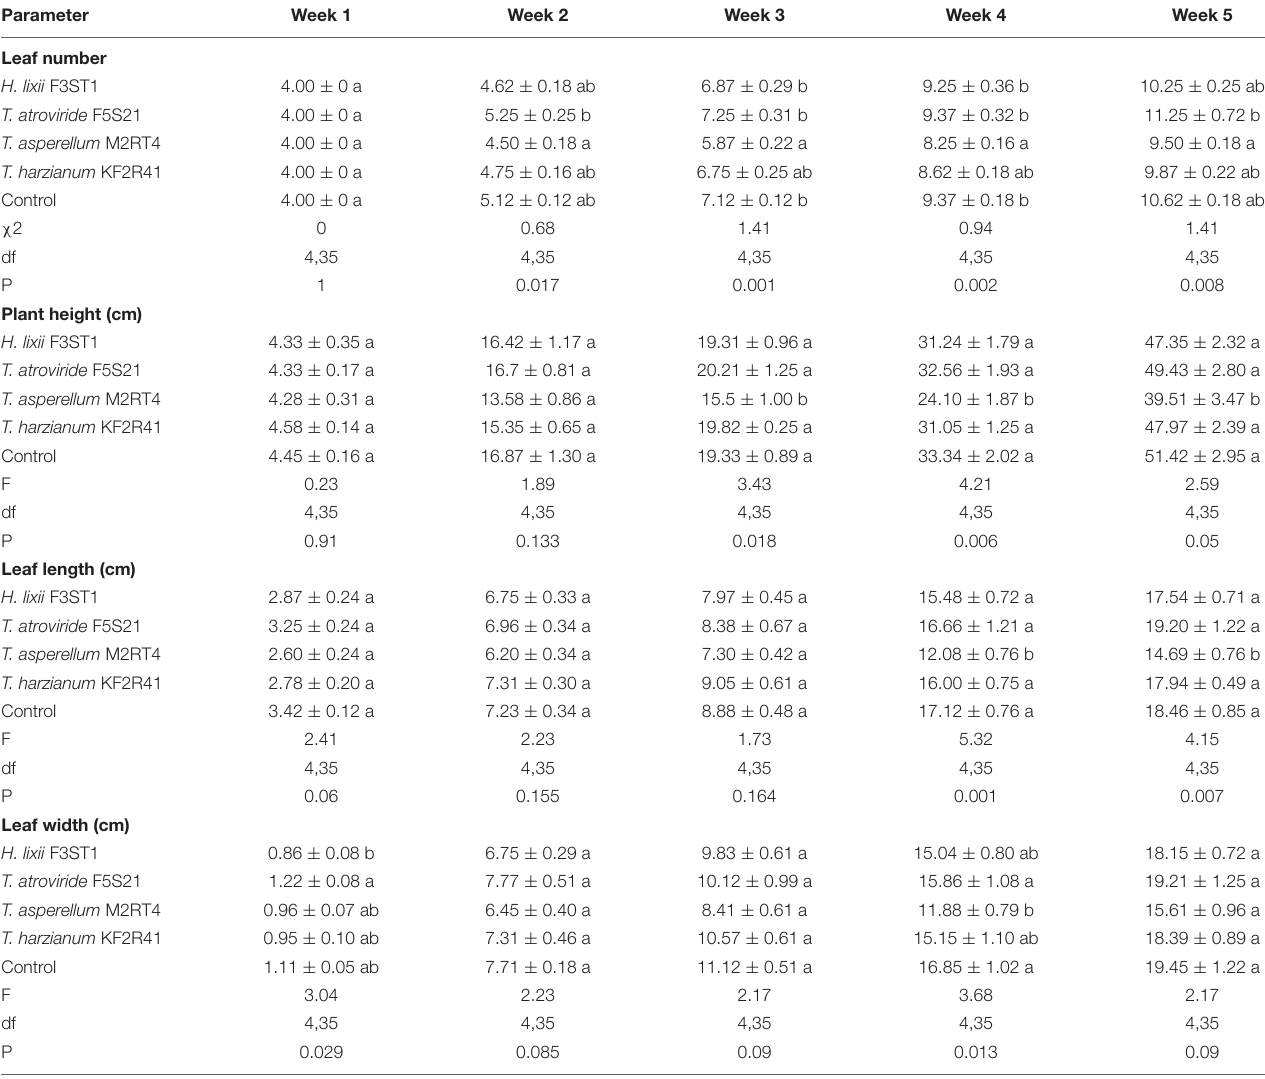
TABLE 1 | The effects of the seed inoculation of Hypocrea lixii F3ST1, Trichoderma asperellum M2RT4, T. atroviride F5S21, and T. harzianum KF2R41 on the growth parameters of Solanum lycopersicum.